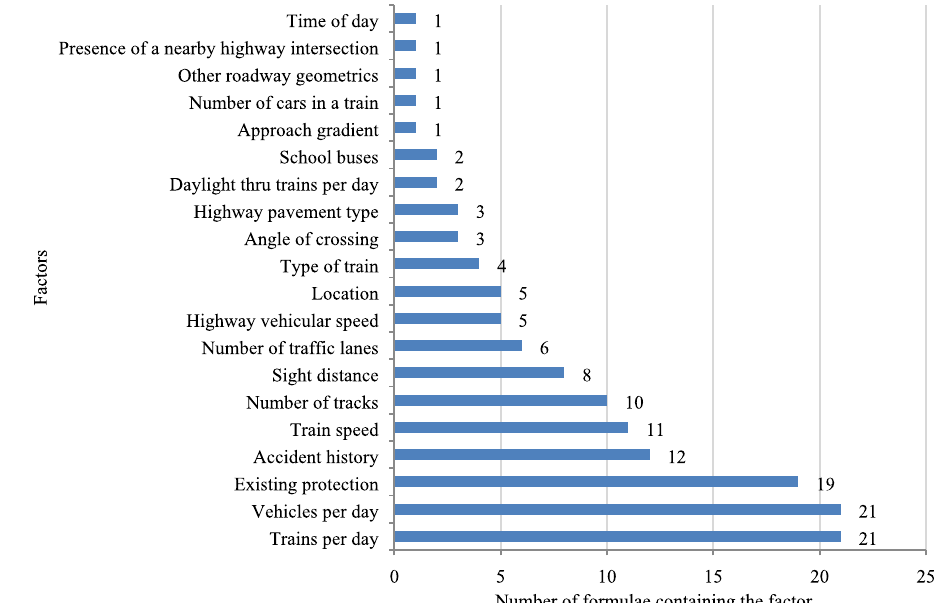
Fig. 8 A distribution of the factors considered by the identified accident and hazard prediction